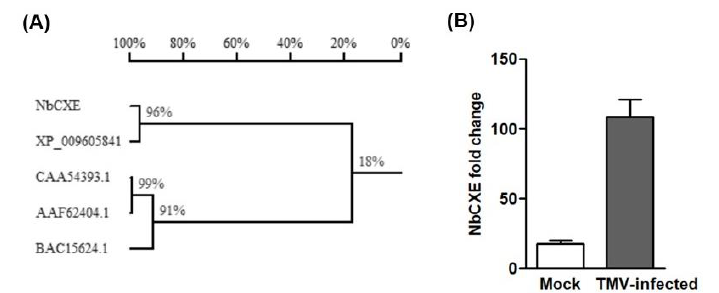
Figure 1. ( A ) Alignment of amino acid sequence of NbCXE with carboxylesterase in Nicotiana sylvestris and the Hsr203J proteins in Nicotiana tabacum . (XP_009605841 are the carboxylesterases in Nicotiana sylvestris ; CAA54393.1, BAC15624.1 and AAF62404 are Hsr203J proteins in Nicotiana tabacum ). ( B ) Expression of NbCXE showed a significant increase at 4 dpi in TMV-infected N. benthamiana plants.